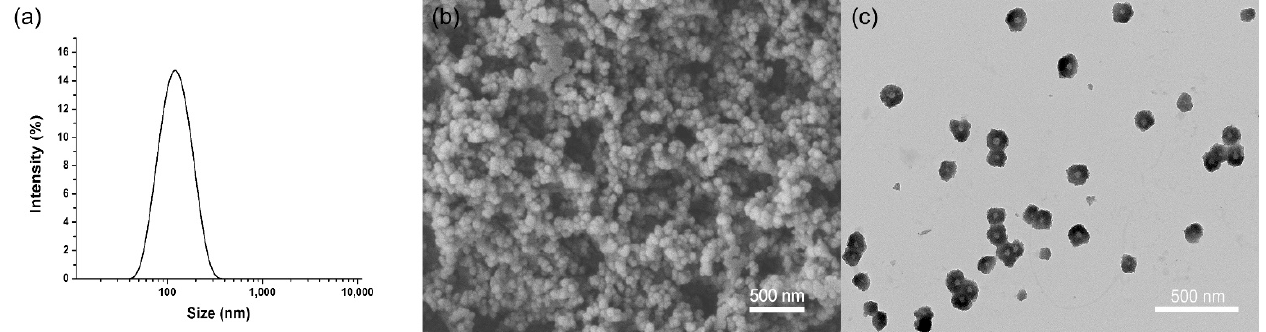
Figure 1. Characterization of particle size and morphology of the buprofezin nanoparticles. ( a ) DLS image of BNPs, ( b ) SEM image of BNPs, ( c ) TEM image of BNPs.